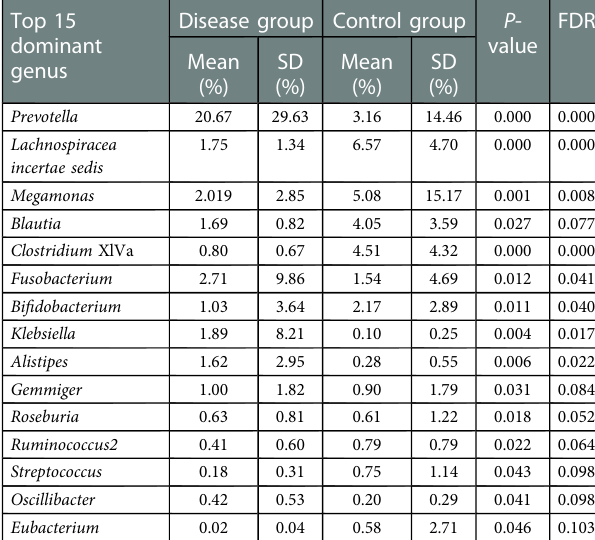
TABLE 3 Comparison of the top 15 dominant bacterial genera in the two groups of children. Top